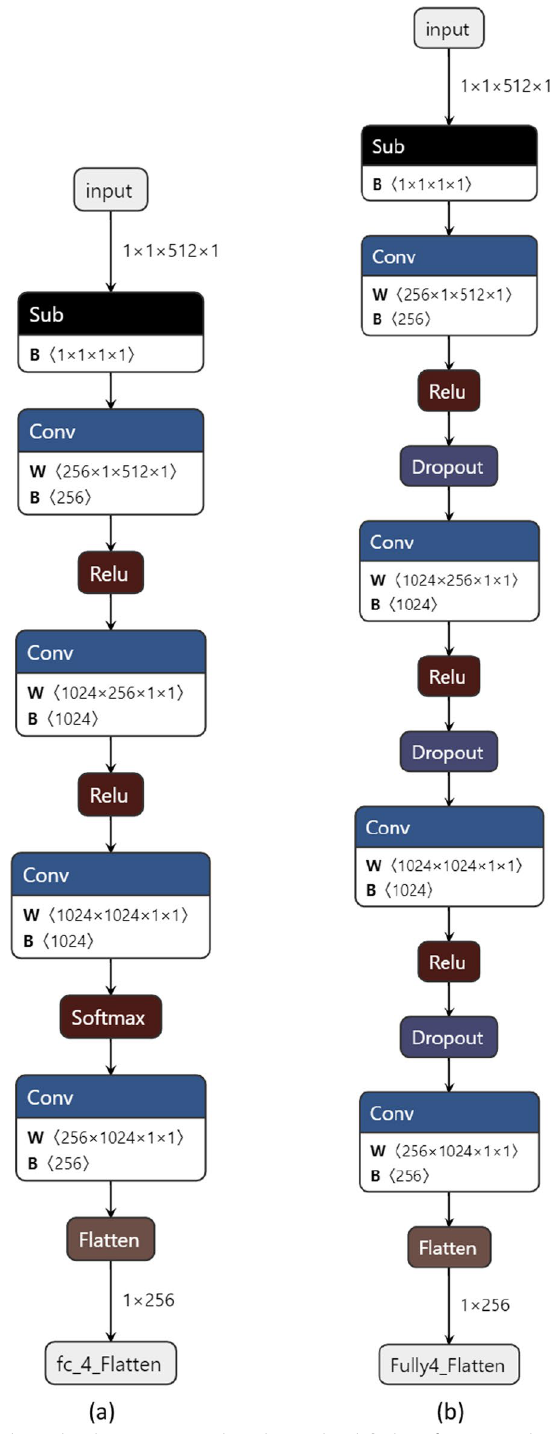
Fig. 7 The DL models used with a EXP3/FTPL algorithm and with b the reference method [26] generated using